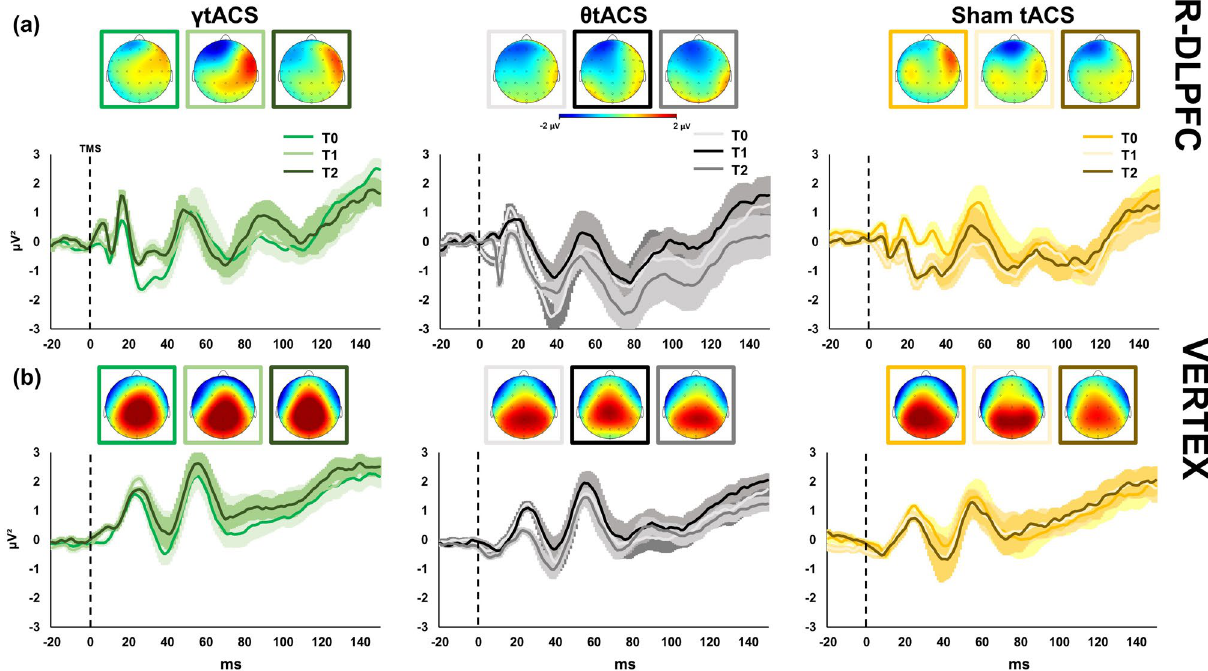
Figure 6. Local transcranial magnetic stimulation (TMS)-evoked cortical response of left dorsolateral prefrontal cortex (l-DLPFC, panel ( a )) and Vertex (panel ( b )). Left side graphics depict TMS-evoked